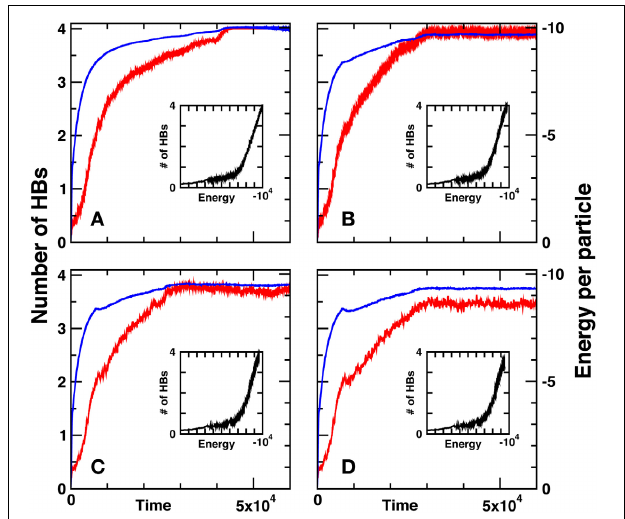
FIGURE 7 | Time evolution of the total potential energy vs. the LB time steps together with the number of hydrogen bonds for four different effective temperatures, at (A) β − 1 = 10 − 4 , (B) β − 1 = 4 × 10 − 4 , (C) β − 1 = 5 . 5 × 10 − 4 , and (D) β − 1 = 7 × 10 − 4 . Main parameters are as follows N = 10 3 , σ R = 0 . 28, σ θ = 0 . 28, and R HB = (